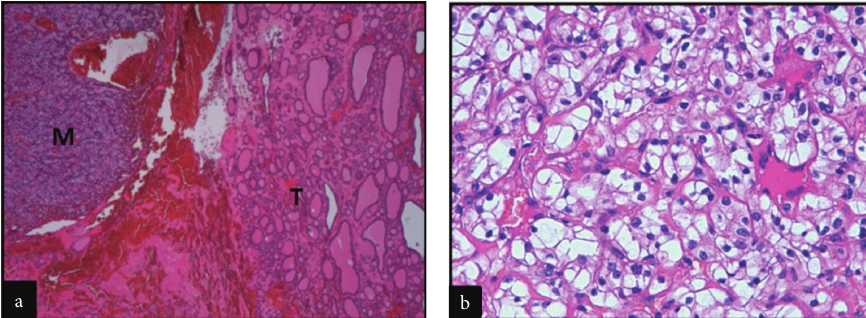
Figure 3: Representative histological (hematoxylin-eosin stain, 40x) micrographs showing normal thyroid tissue (T) and metastatic tissue (M) (a). A greater (400x) magnification of the metastatic tissue, featuring large cells arranged in nests and cords with optically clear cytoplasm and enlarged nuclei displaying coarse chromatin, is shown in section (b).